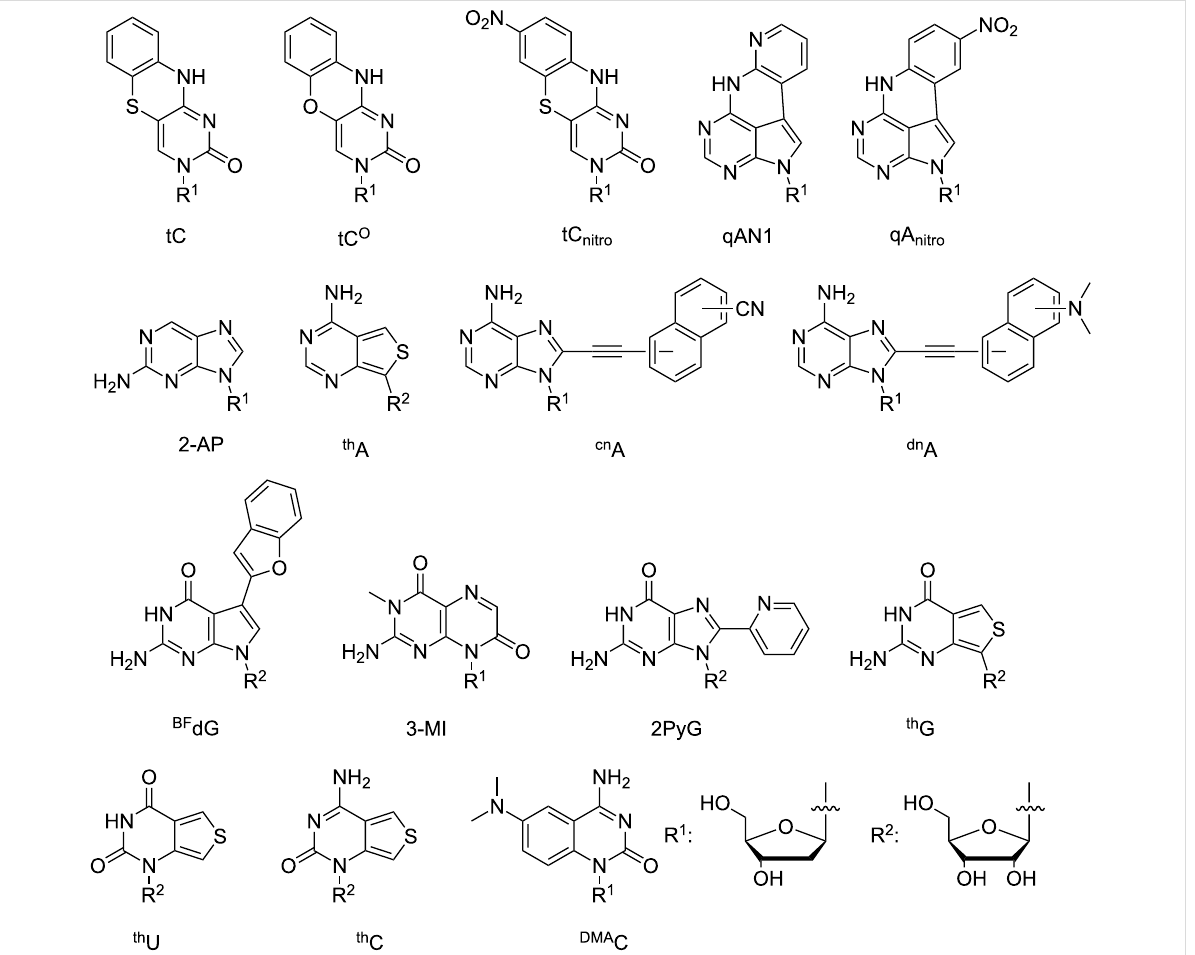
Figure 2: Notable recent examples of fluorescent base analogues. For cn A and dn A the attachment point to the substituted naphthalene moiety has been varied.